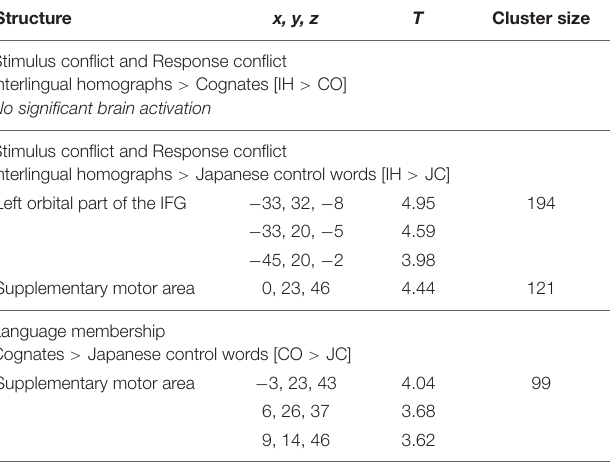
TABLE 2 | Brain activation patterns associated with cross-linguistic effects.